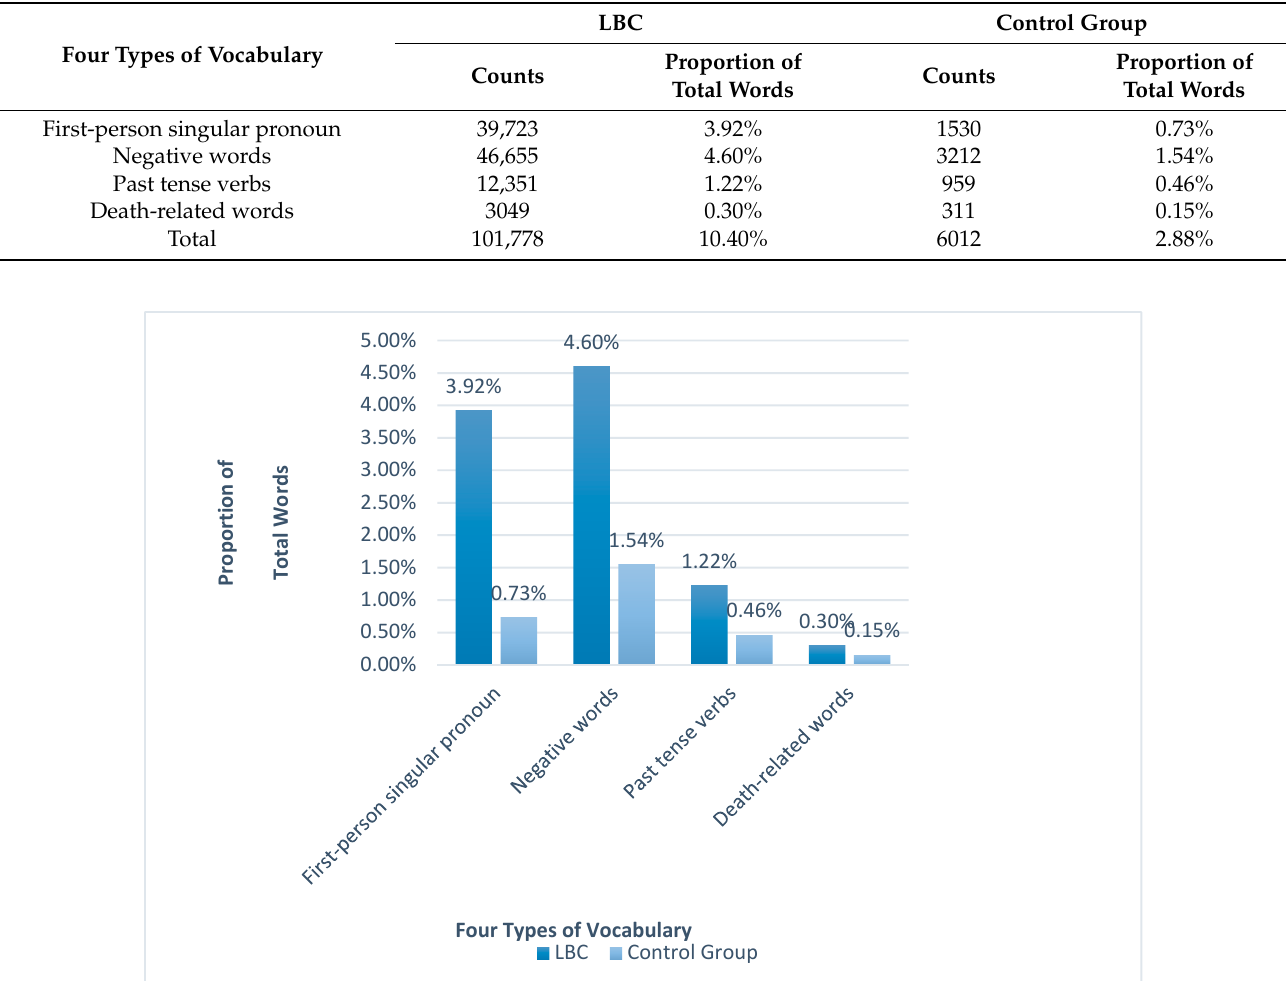
Figure 2. Histogram of four types of vocabulary between the LBC group and the control group.